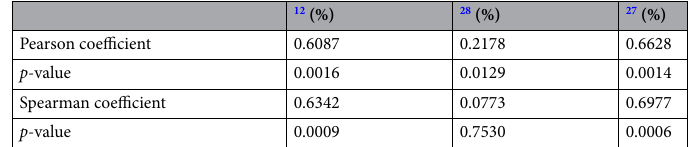
Table 3. Pearson and Spearman correlation coefficients and p -values of physical sign frequencies in subjects with DS found in the present study compared with previous works. Frequencies expressed as percentages are taken from Table